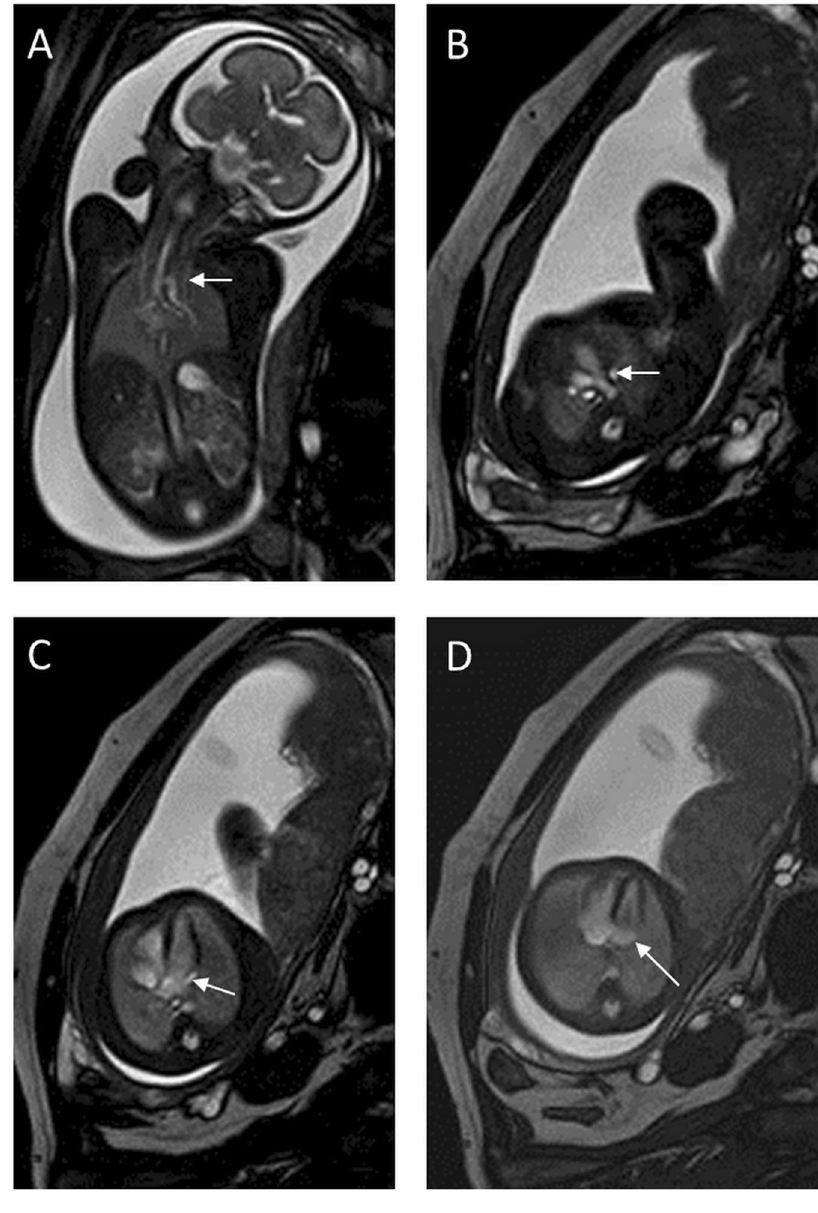
Figure 1. A 27-week fetus with persistent left superior vena cava. Fetal CMR B-TFE coronal and transverse views of the aortic arch show persistent left superior vena cava (LSVC) on the left side of the aortic arch